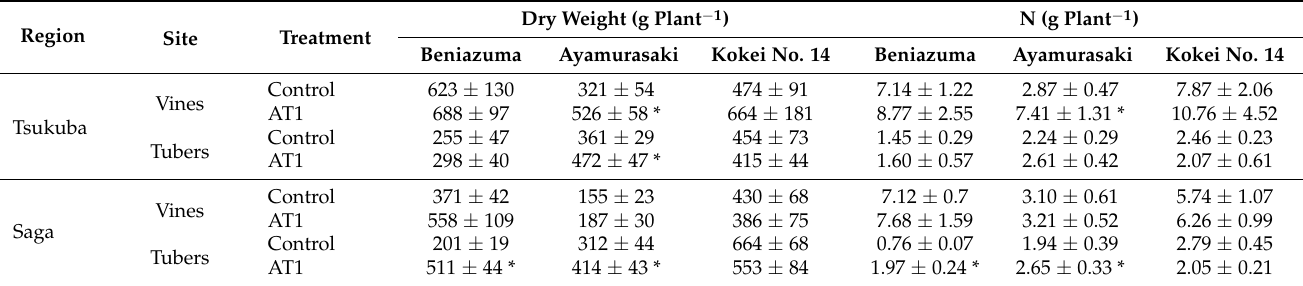
Table 4. Effects of Bradyrhizobium sp. AT1 inoculation on the growth and N content of field-grown sweet